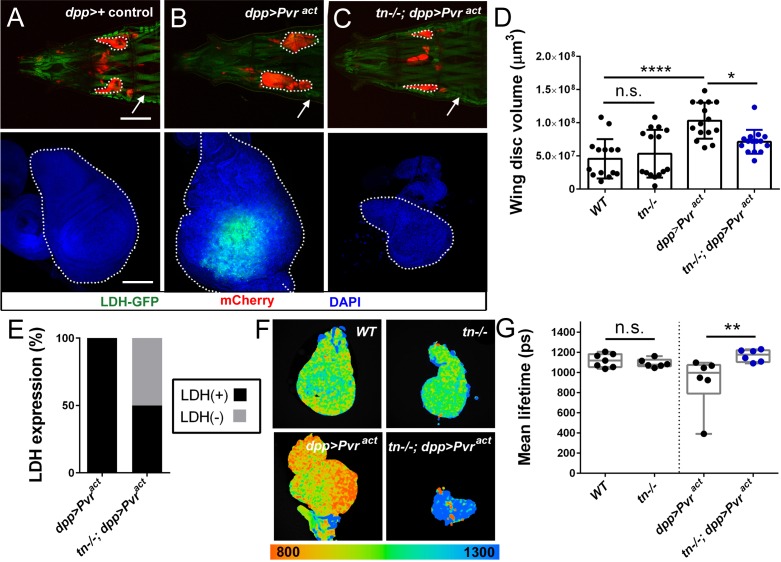
Loss of TRIM32 reduces Pvr-induced glycolytic tumor growth.(A–C) Either intact (upper panel; red) or isolated (lower panel, blue) wing discs from L3 larvae of the indicated genotypes. LDH-GFP is high in somatic muscles (white arrow). Wing discs are outlined (white dotted outlines). (A) The normal size and shape of control dpp-Gal4/+ wing discs. (B) Overexpression of the activated Pvr receptor (dpp >Pvract) causes tissue overgrowth and an increase in LDH-GFP expression (green). (C) Tumor growth in a tn-/- host is dramatically reduced in size. (D) Overall wing disc volumes are represented in this column plot. N ≥ 15. (E) Approximately 50% of LDH-GFP(+) cells induced by activated Pvr expression is reduced upon loss of TRIM32. N = 20. (F) Representative fluorescence lifetime micrographs of control (WT or tn-/-) or tumorous (dpp >Pvract or tn-/-; dpp >Pvract) wing discs. (G) Box and whisker plot confirms no difference in the glycolytic profile between WT or tn-/- discs. The decreased lifetime in dpp >Pvract discs, indicative of higher glycolytic flux, is reduced upon loss of TRIM32. N = 6. Mean +/- SD. (****, p<0.001; *, p<0.05; n.s., not significant). Scale bars: 0.5 mm (A-C, upper panels), 100 µm (A-C, lower panels).